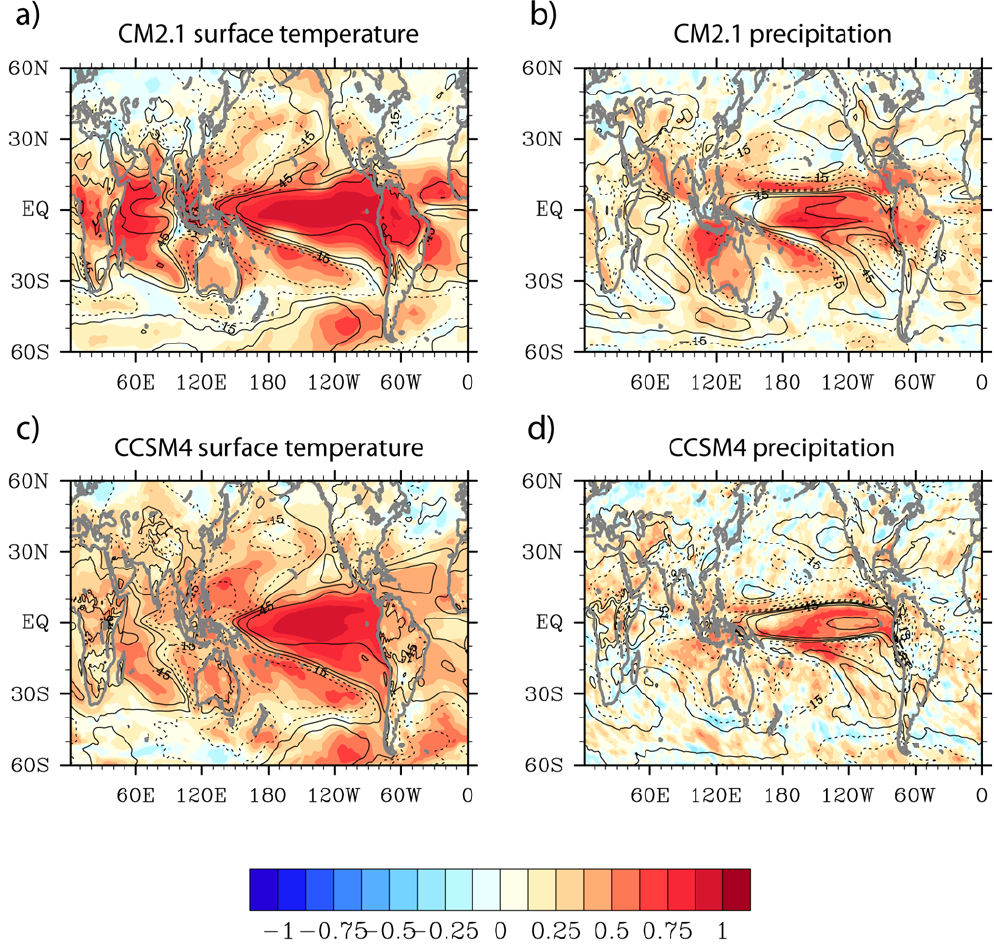
Fig. 2. Correlation between the running variance of the (a) simulated surface temperature ( T S ) and (b) precipitation running variance with the running variance of the simulated ENSO index (defined as the area-averaged T S in the Niño 3.4 region) in CM2.1. The overlying contours in panels (a) and (b) represent the correlations between simulated T S and rainfall, respectively, with the simulated ENSO index. Contours are from − 0.75 to 0.75 with a spacing of 0.3 and negative contours are dashed. (c) and (d) as in (a) and (b) , respectively, but for CCSM4 model